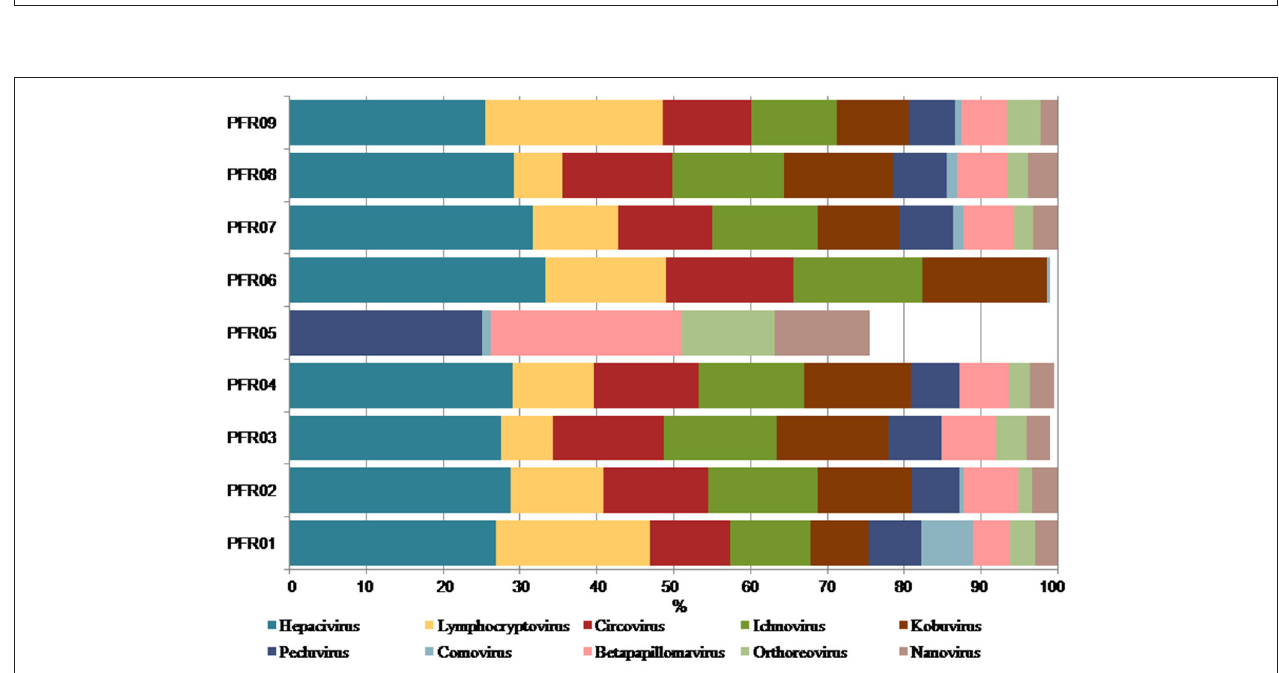
FIGURE 6 | Increase in the abundance of discriminative viral genera in PFR samples compared to mean abundance in the control group.